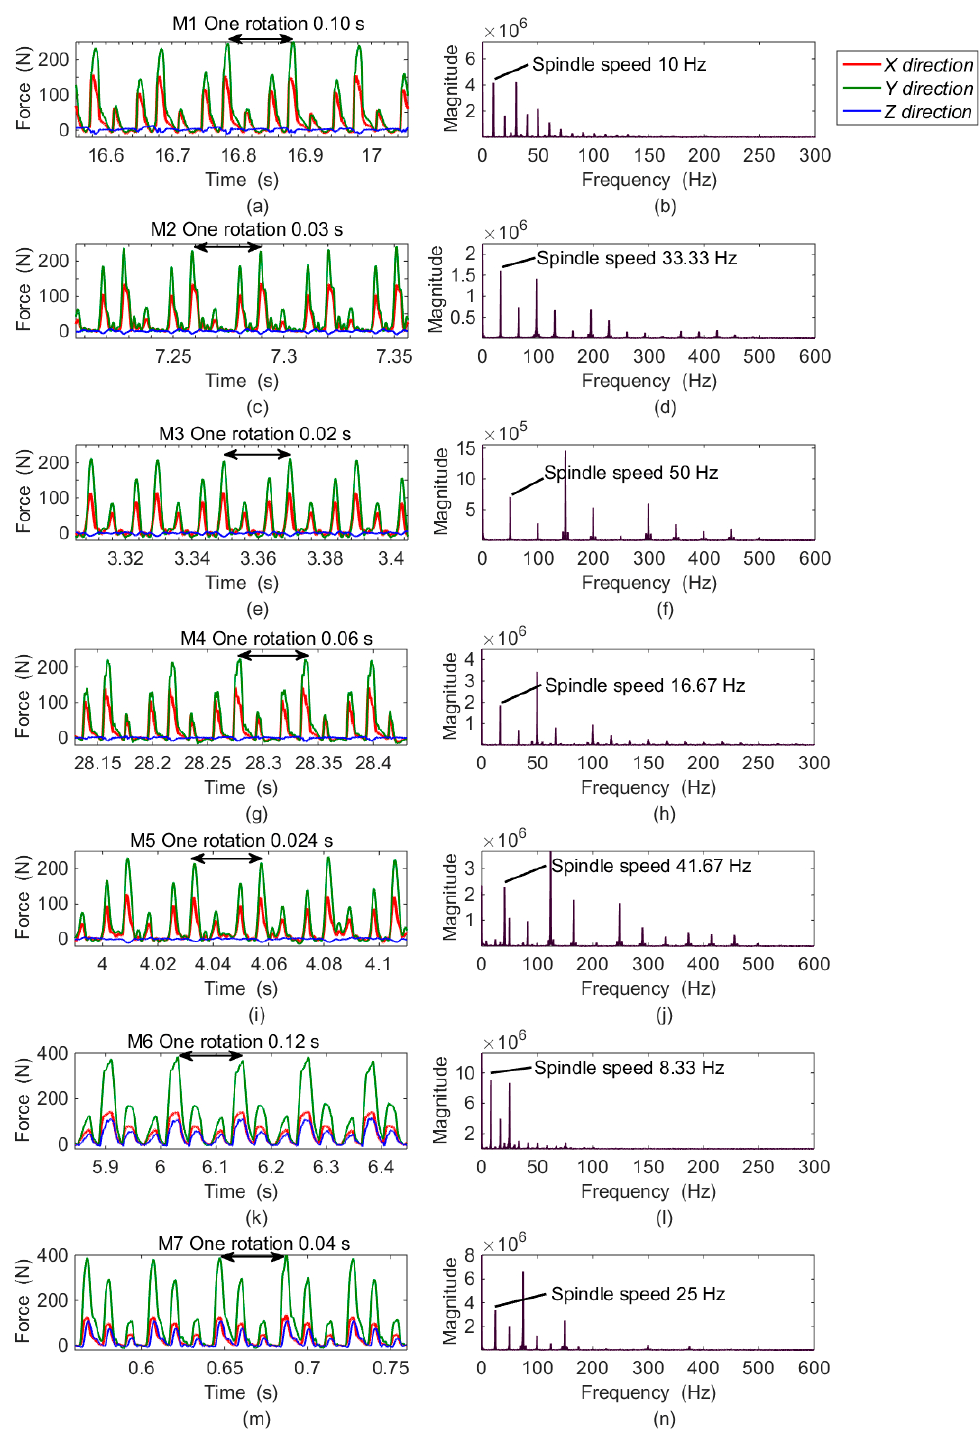
Figure 13. The partial enlarged view of milling forces in different positions: ( a ) forces of M1B in the time domain; ( b ) F X of M1B in the frequency domain; ( c ) forces of M2B in the time domain; ( d ) F X of M2B in the frequency domain; ( e ) forces of M3B in the time domain; ( f ) F X of M3B in the frequency domain; ( g ) forces of M4B in the time domain; ( h ) F X of M4B in the frequency domain; ( i ) forces of M5B in the time domain; ( j ) F X of M5B in the frequency domain; ( k ) forces of M6B in the time domain; ( l ) F X of M6B in the frequency domain; ( m ) forces of M7B in the time domain; ( n ) F X of M7B in the frequency domain.